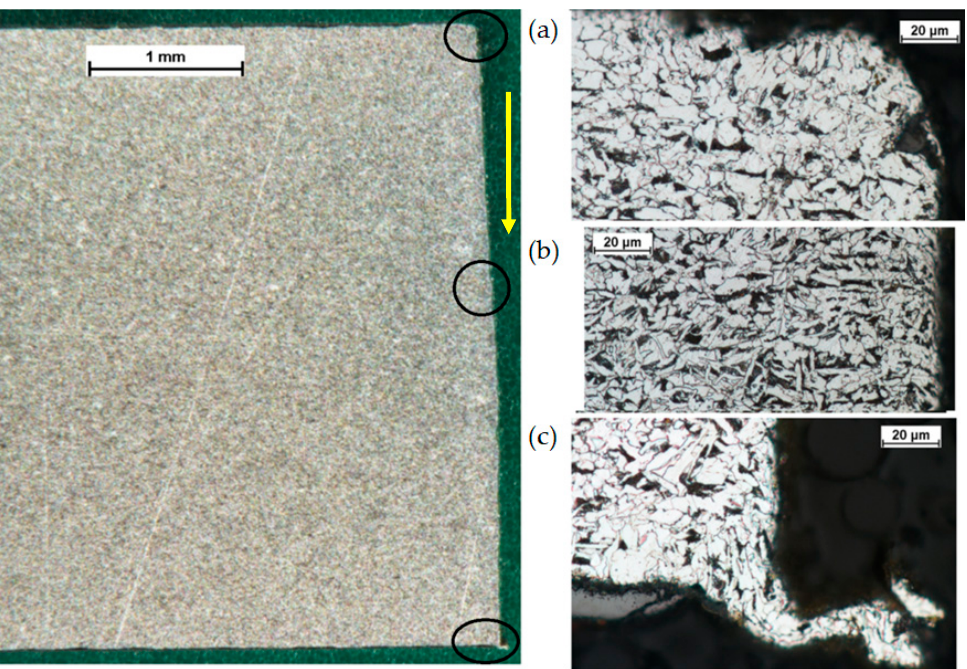
Figure 4. S235JR steel specimen cut with a pressure of 380 MPa and a cutting speed of 250mm/min: ( a ) water jet entry zone, ( b ) middle zone, ( c ) water jet exit zone.